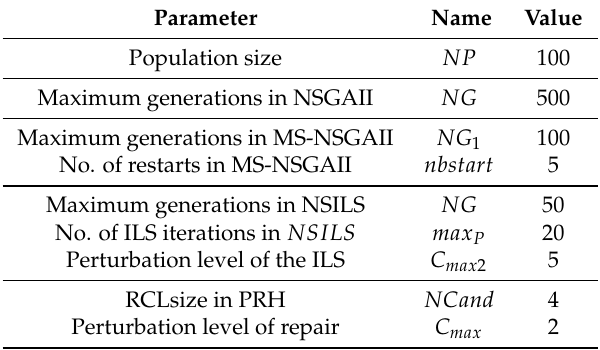
Table 8. Fixed parameters. PRH, Parallel Randomized constructive